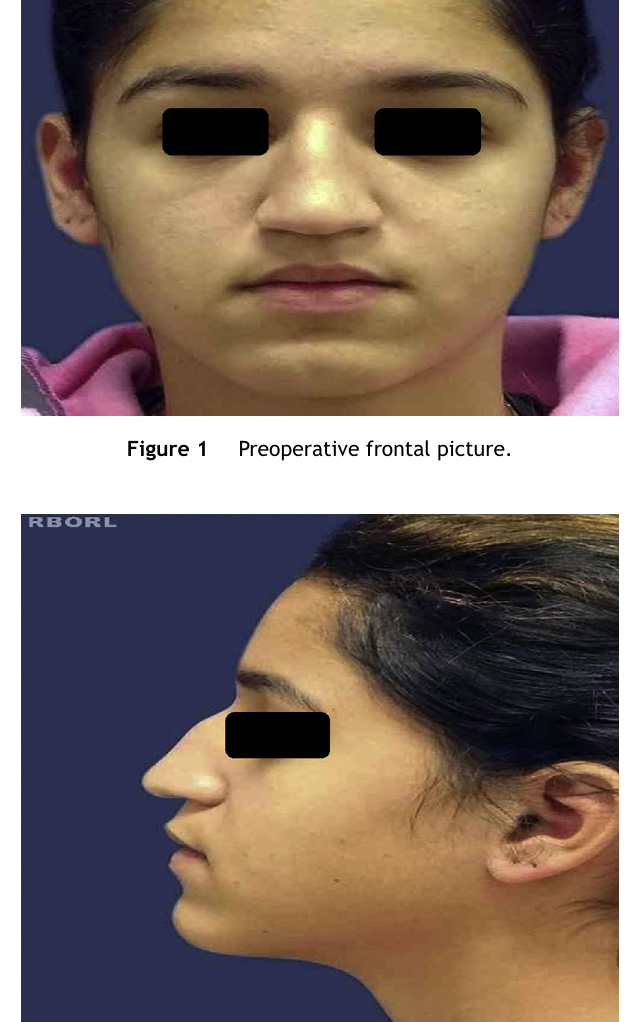
Figure 2 Preoperative profile picture.